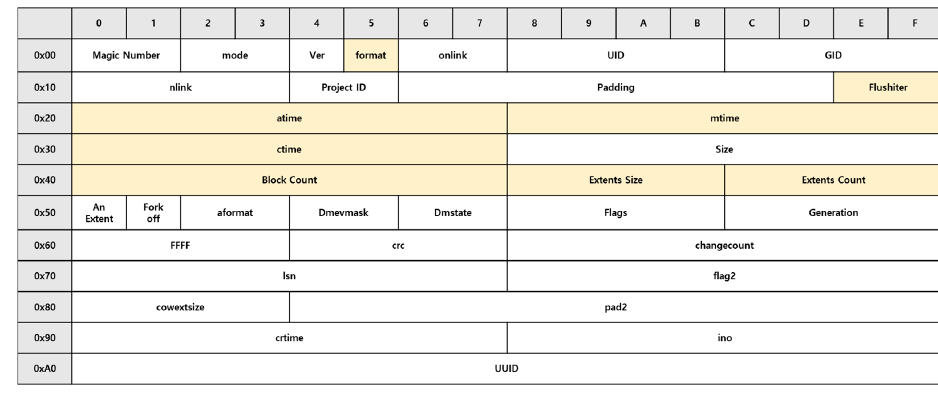
Figure 7. Inode core structure of XFS file system.